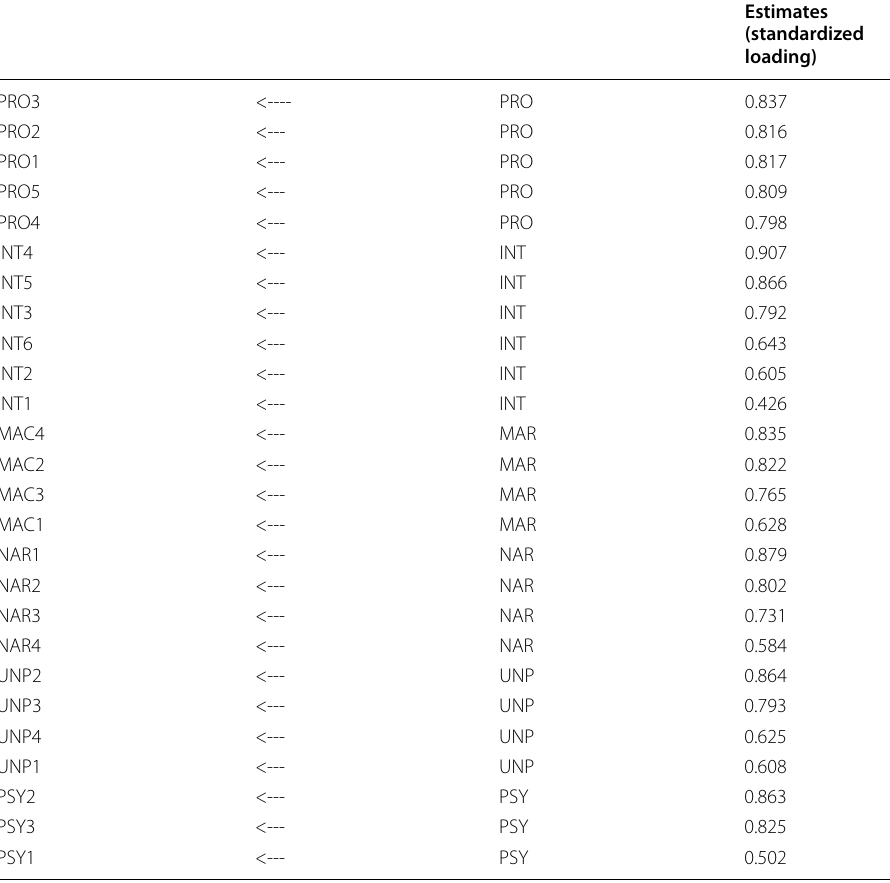
Table 5 Standardized loading estimates of